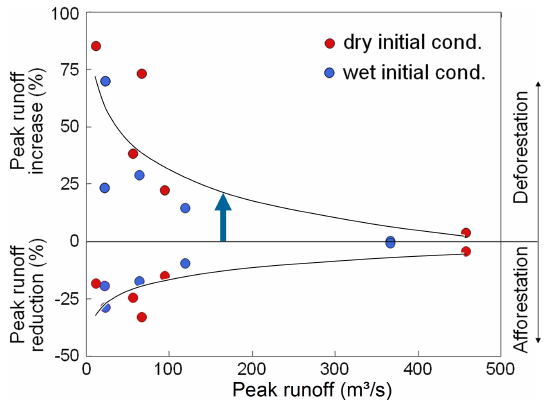
Figure 4. Effect of land-use change on flood peak runoff for the 622km 2 Kamp catchment at Zwettl in Austria, using a distributed rainfall–runoff model. Upper part of the figure: increase in peak runoff of a scenario of complete deforestation relative to the ob- served baseline case of 47% forested area, plotted against the peak runoff of the baseline case. Lower part of the figure: same but for afforestation (increase in forested area from 47% to 86%). Each point represents one event, and the initial soil moisture is shown in colour. Deforestation reduces infiltration and thus increases sur- face runoff. The effect decreases as the event magnitude increases. Modified from Salazar et al.